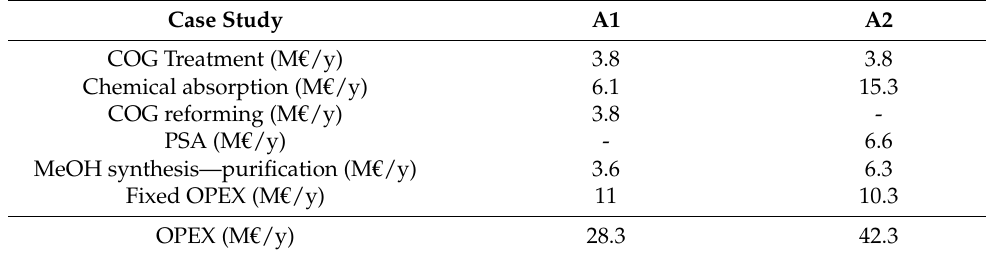
Table 8. Distribution of OPEX by type of operation units for case studies A1 and